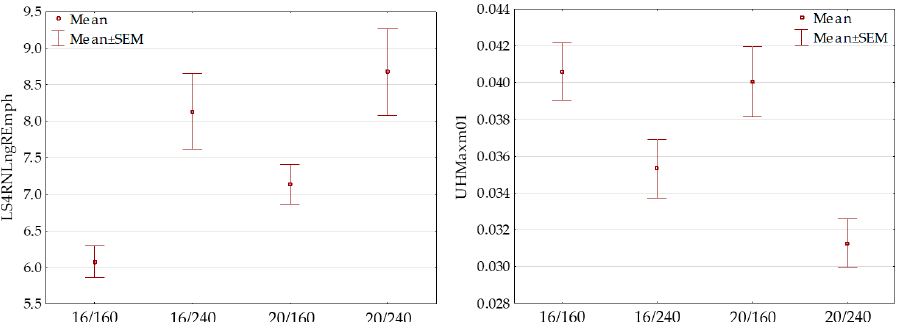
Figure 7. The values of selected image textures of the cv. ‘Elizium’ lettuce leaves; SEM—standard error of the mean.